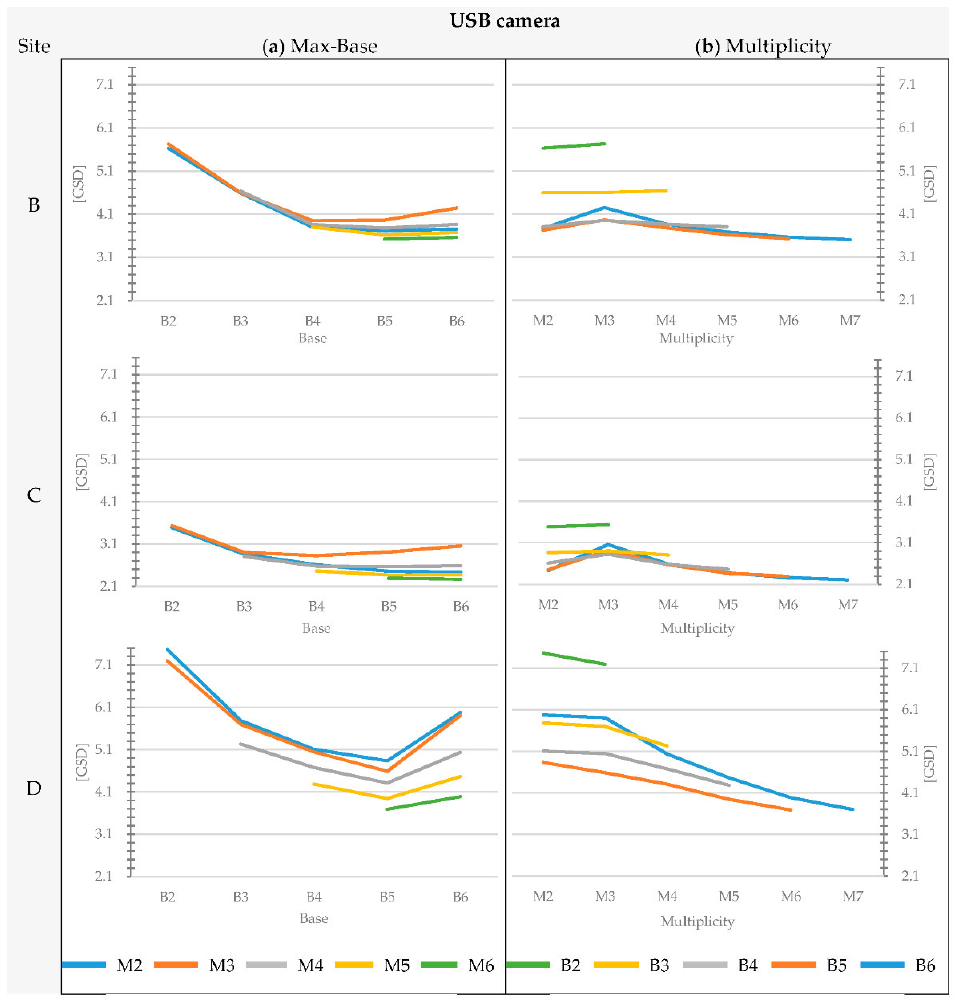
Figure 9. Graphs showing the standard deviation of the elevation disparity between DEMs and the reference model for Sites B, C and D, using USB camera, as a function of ( a ) max-base variability and ( b ) multiplicity. (Value of standard deviation for combinations B1-M2: Site B = 9.09, Site C = 5.79 and Site D = 12.71 times the GSD).